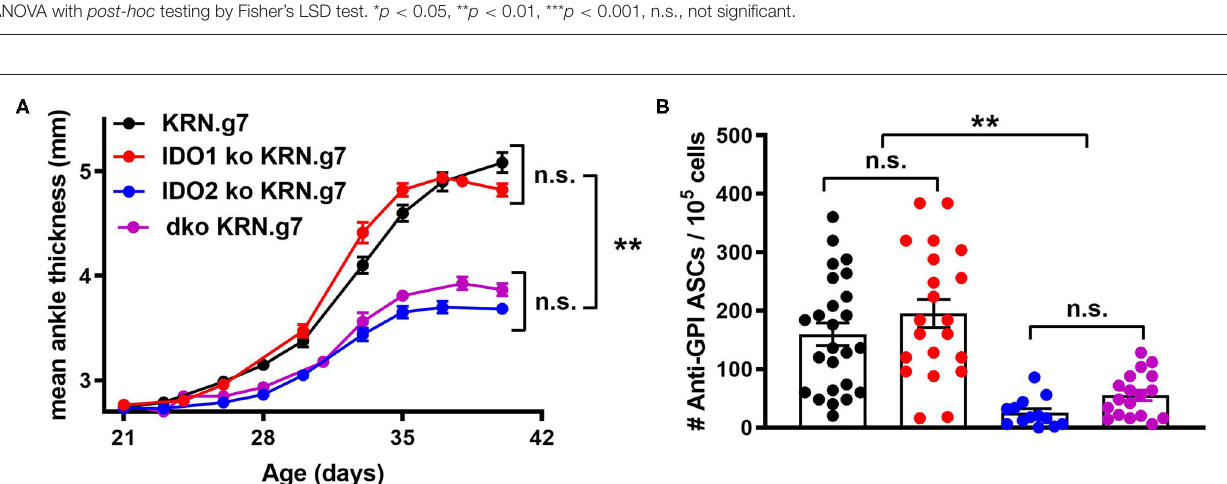
FIGURE 1 | mean ± SEM of IDO1 and IDO2 relative to β 2M for n = 6 pools/genotype. (C,D) Protein lysates from (C) epididymis, (D) liver, (E) unstimulated/activated B cells, and (F) unstimulated/activated T cells from IDO1 ko, IDO2 ko, dko, or wt C57BL/6 mice were immunoblotted with antibodies to IDO1 and IDO2. Blots were then probed with anti-GAPDH as a loading control. Representative blot of 3 total. Molecular weights are indicated. The IDO2-specific band is indicated with an arrow. Symbols represent individual mice and histograms show the mean ± SEM ratio of (G) IDO1 or (H) IDO2, normalized to GAPDH, relative to the C57BL/6 control for n = 3 blots. (I) Serum and unstimulated/activated B and T cells supernatants (48h) were analyzed for kynurenine (Kyn) by ELISA. 293-T-REx TM cells stably transfected with murine IDO1, IDO2, or untransfected controls (parental) were used as positive controls for enzyme activity. Symbols respresent individual mice (serum) or pools of 3 mice (B and T cells) and histograms show the mean ± SEM for n = 6/genotype (serum) and n = 3/genotype (B and T cells). P -values were calculated by two-way ANOVA with post-hoc testing by Fisher’s LSD test. * p < 0.05, ** p < 0.01, *** p < 0.001, n.s., not significant.